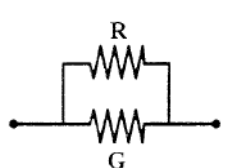
Figure 3. Parallel connection for compensation of the bridge offset output voltage.